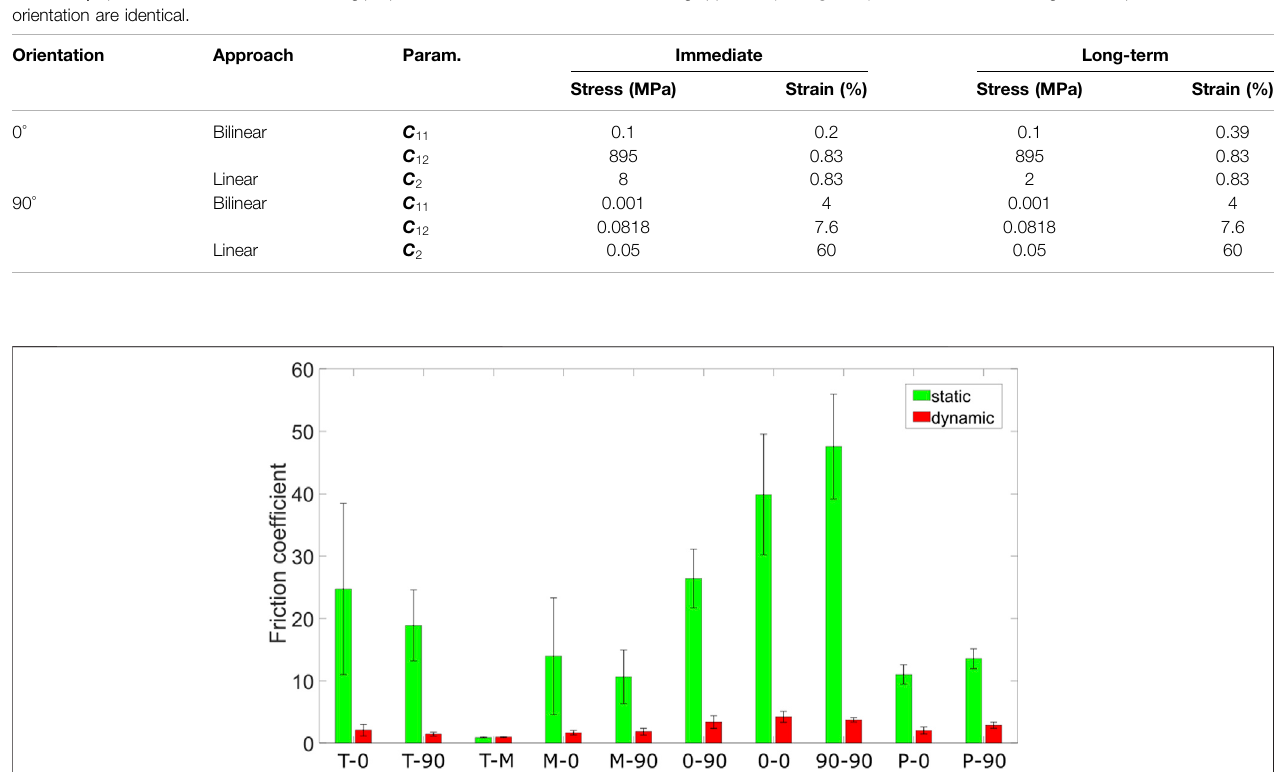
FIGURE 10 | Static and dynamic friction coef fi cients for the individual contact pairs occurring in the single diaphragm process: Tool (T), Membrane (M), Ply-0 ° (0), Ply-90 ° (90), and PTFE fi lm (P).